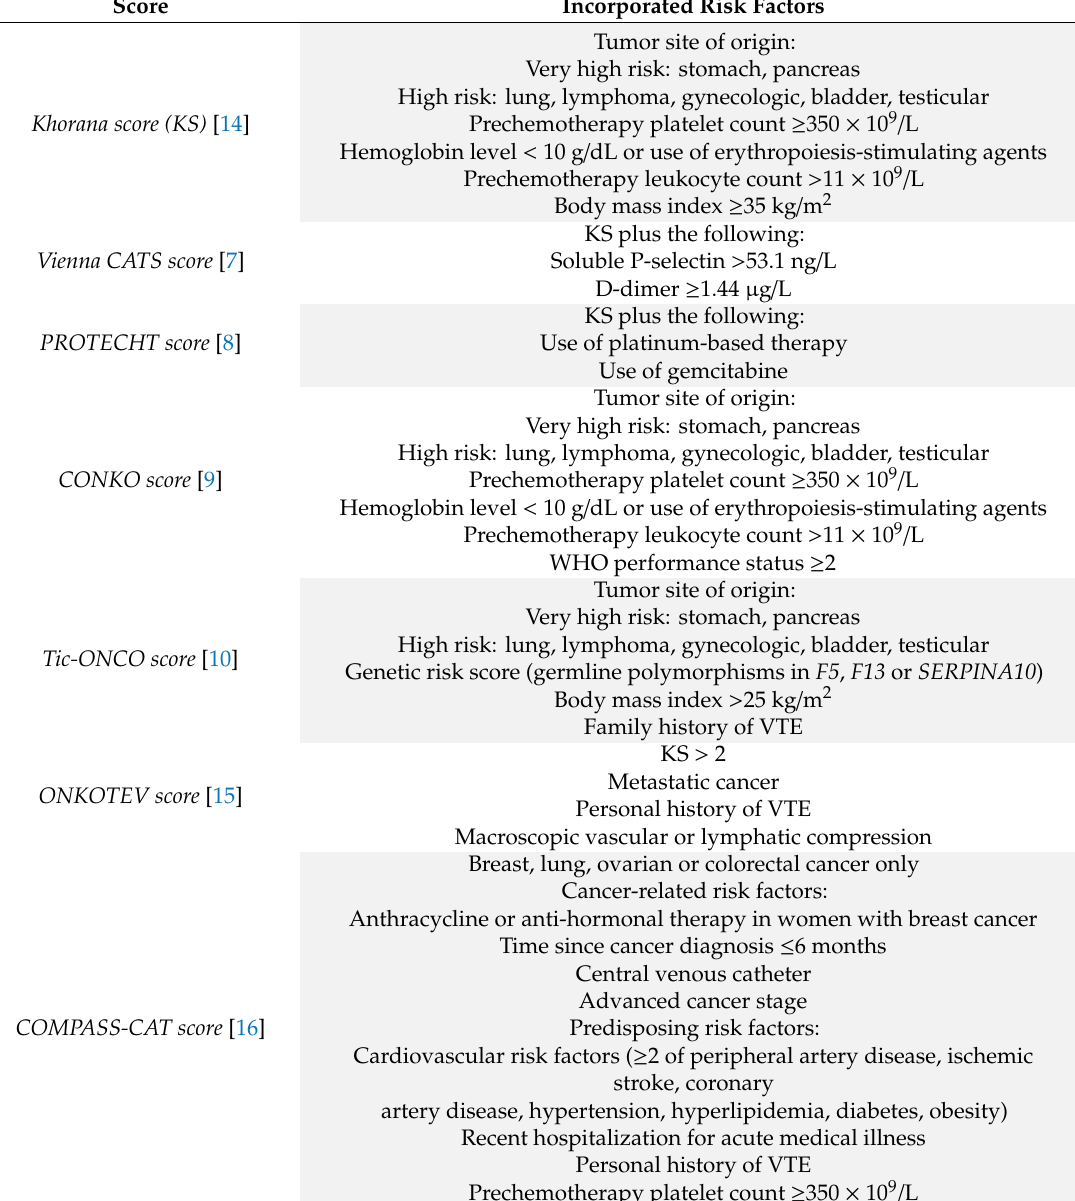
Table 1. Risk stratification models for venous thromboembolism (VTE) risk in cancer patients. Adapted with permission from Song et al.